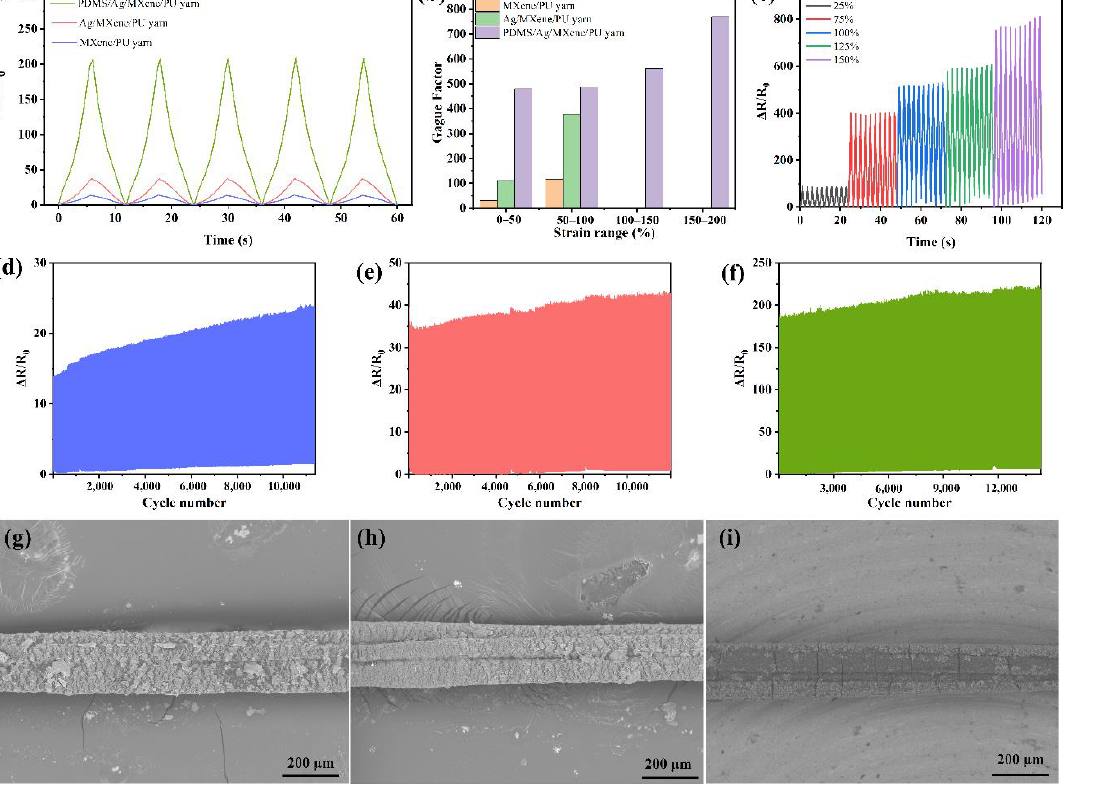
Figure 4. ( a ) Different strain-sensing yarns tested under 5 stretching/releasing cycles, ( b ) gauge factors of different strain-sensing yarns under different strain range, ( c ) signal response of PDMS/Ag/MXene/PU yarn under different tensile ranges, ( d ) cyclability of MXene/PU yarn with an applied strain of 50%, ( e ) cyclability of Ag/MXene/PU yarn with an applied strain of 50%, ( f ) cy- clability of PDMS/Ag/MXene/PU yarn with an applied strain of 50%, ( g ) SEM images of MXene/PU yarn with an applied strain of 50%, ( h ) SEM images of Ag/MXene/PU yarn with an applied strain of 50%, ( i ) SEM images of PDMS/Ag/MXene/PU yarn with an applied strain of